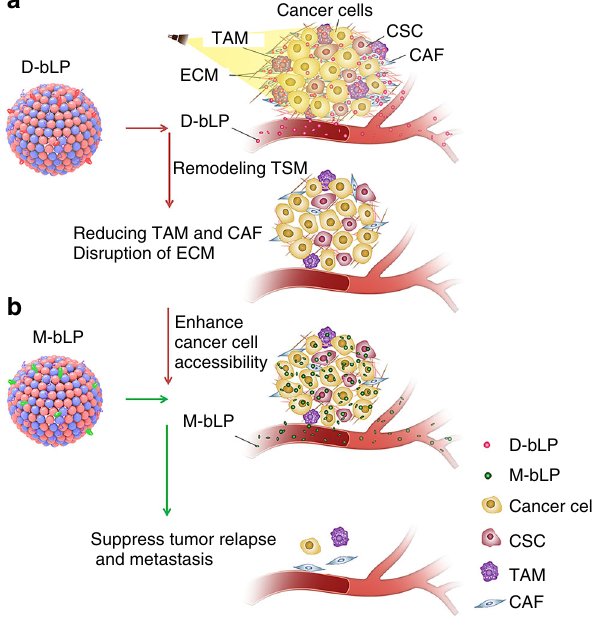
Fig. 1 Schematic illustration of D-bLP-mediated photothermal remodeling of tumor stroma to enhance second M-bLP accessibility to cancer cells. a D- bLP-mediated photothermal effects cause drastic elimination of stromal cells (e.g., CAF and TAM) and ECM components (e.g., collagen I, fi bronectin). b D-bLP-mediated TSM remodeling enhances the accumulation and penetration of second M-bLP in tumor, promotes their extravasation from tumor vasculature and accessibility to cancer cells, thus resulting in ef fi cient suppression of tumor relapse and metastasis.